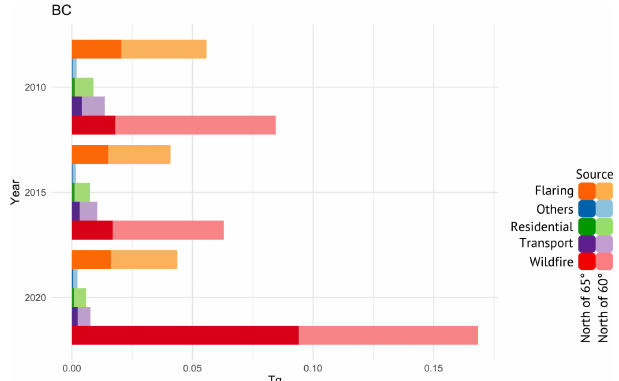
Figure 8. Sectoral black carbon emissions above 60 ◦ N (lighter colours) and 65 ◦ N (darker colours) for 2010, 2015, and 2020; an- thropogenic emissions are from GAINS and wildfire emissions are from